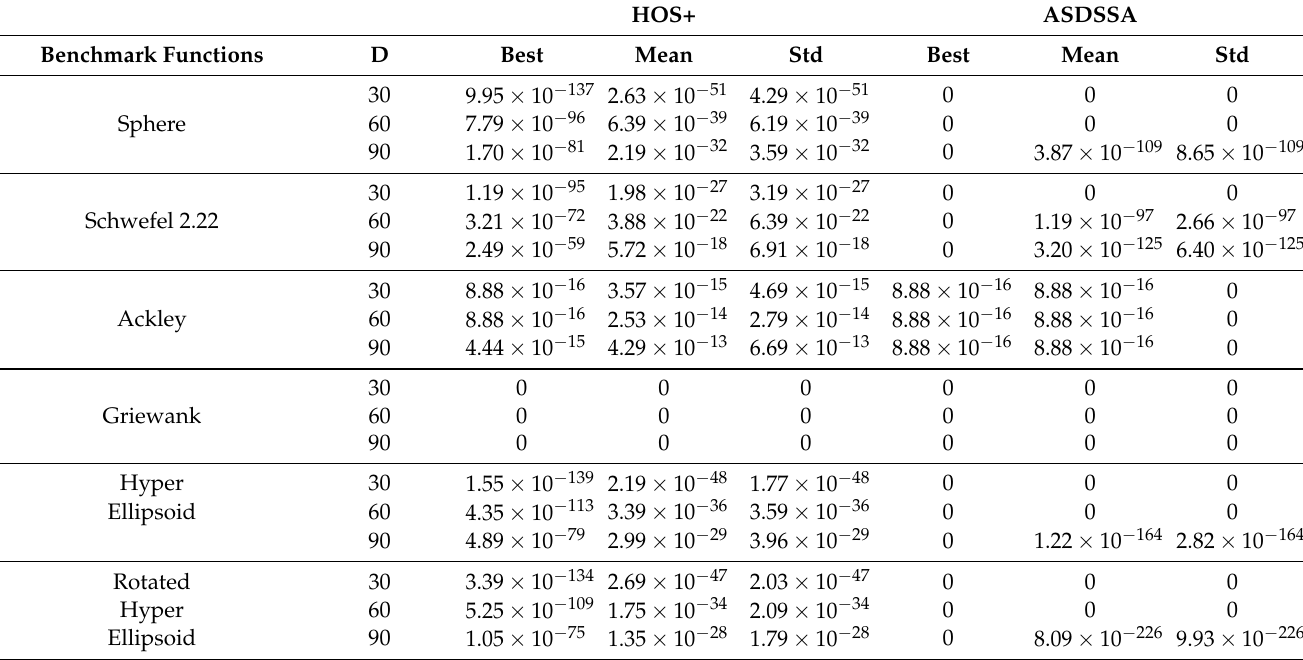
Table 4. The performances of the HOS+ algorithm and the ASDSSA using different numbers of dimensions. HOS+